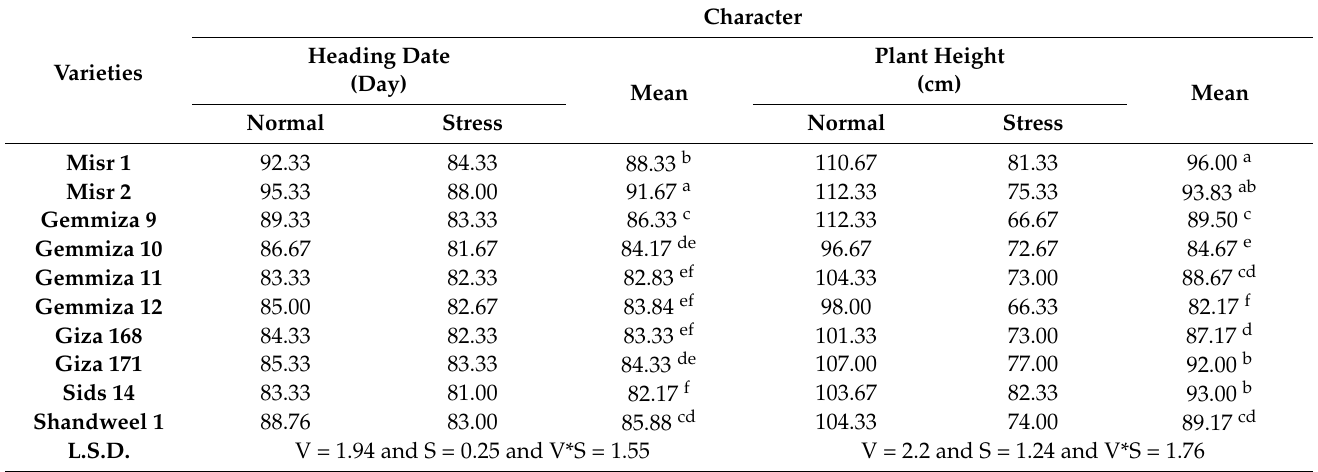
Table 2. Mean values of heading date and plant height traits for ten wheat cultivars under normal and drought conditions. Different letters are significantly different, according to the LSD test, at p < 0.05.